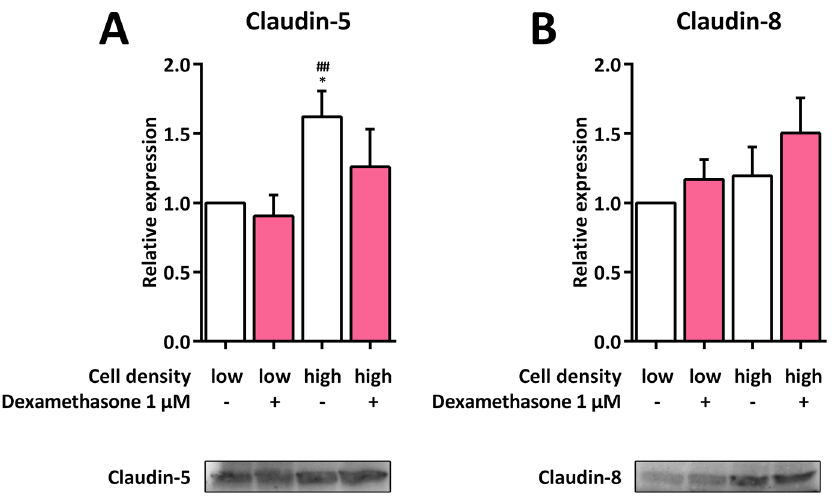
Fig 6. Immunoblots against claudin-5 and claudin-8 from H441 cells at different densities. H441 cells were seeded at low (1 × 10 4 cells per cm 2 ) and high (7.5 × 10 4 cells per cm 2 ) quantitiesand either left untreated or incubatedwith 1 μ M dexamethasone for 48 h. Immunoblots againstclaudin-5( A ) and claudin-8 ( B ) were performed, protein levels were normalizedto total blotted protein, and fold differencescompared to 1 × 10 4 untreated cells per cm 2 were calculated. Means +SD of n = 3 independentexperiments are shown. * p < 0.05 comparedto 1 × 10 4 untreatedcells per cm 2 , ## p < 0.01 comparedto 1 × 10 4 dexamethasone- treated cells per cm 2 .